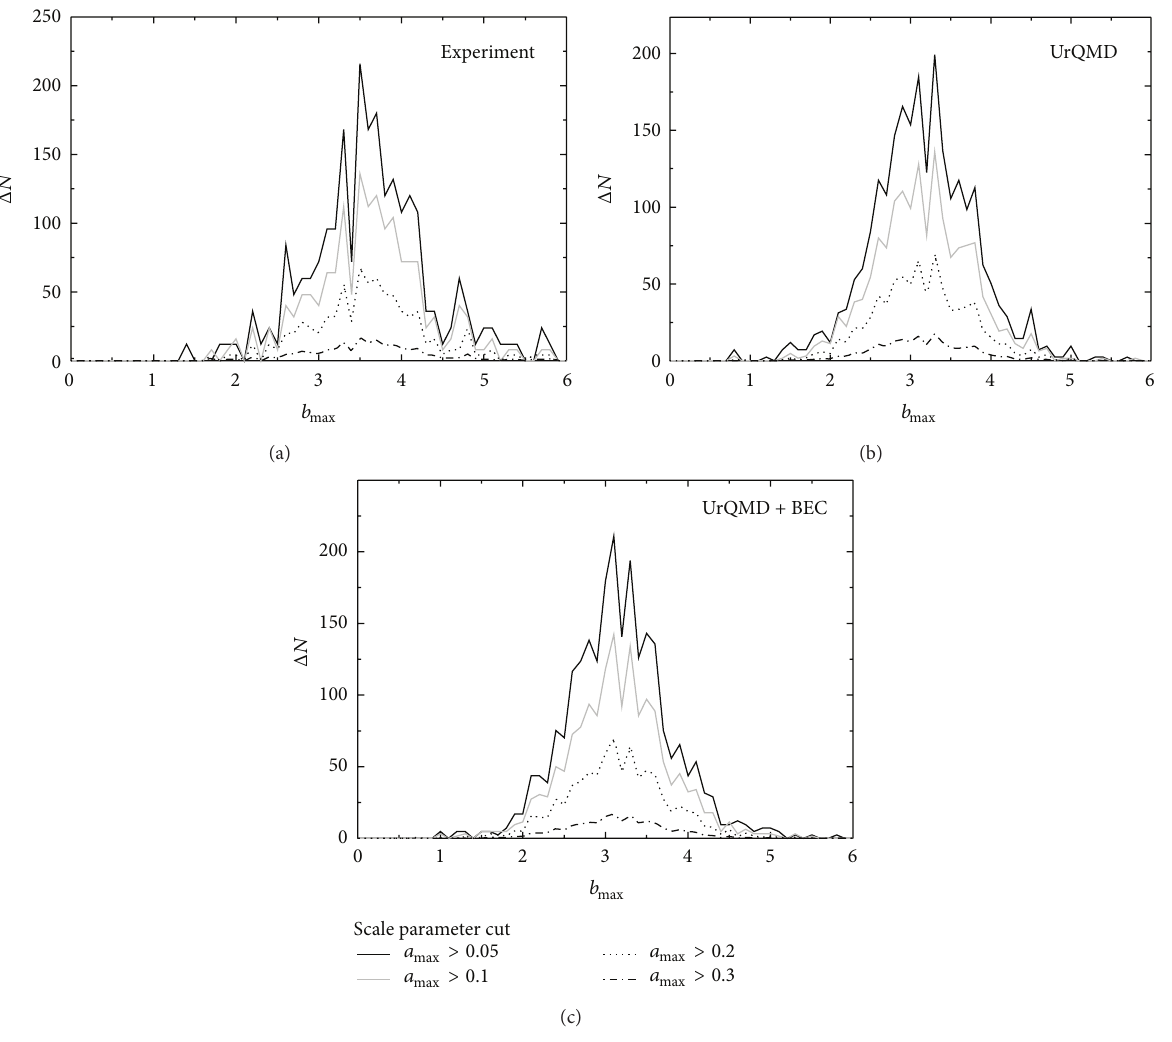
Figure 9: The same as Figure 8 but for 32 S-Ag/Br interaction at